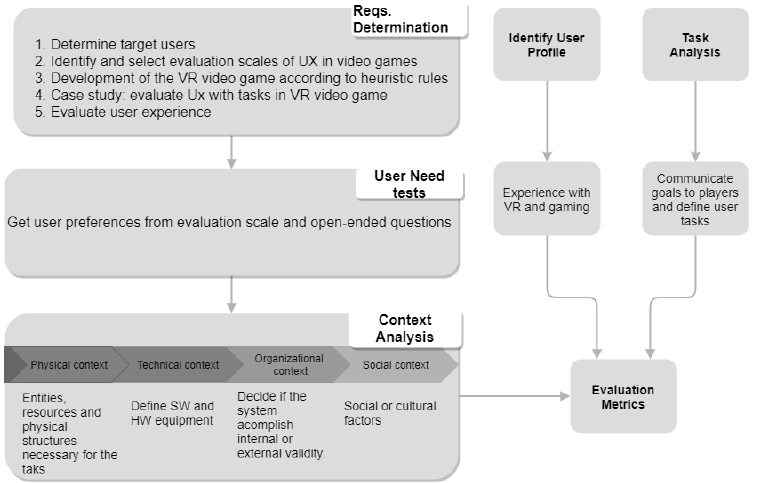
Figure 6. Analysis phase of proposed